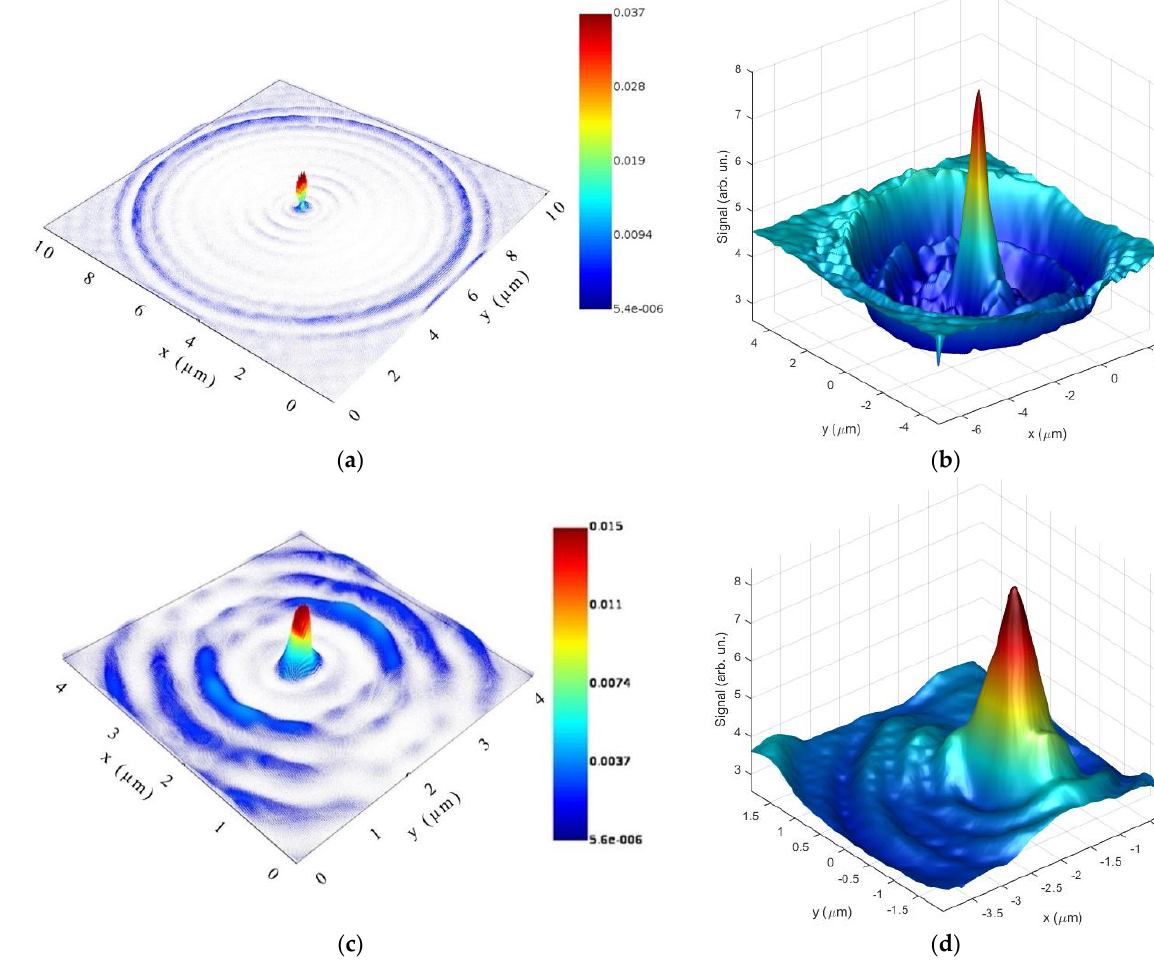
Figure 6. FDTD simulation of electric field distribution of MRZ structure illuminated by 420 nm LED source in scanning field of ( a ) 10 × 10 μm 2 650 nm above the surface and ( b ) measured near-field intensity; detail field map of 4 × 4 μm 2 ( c ) simulation and ( d ) NSOM measurement.